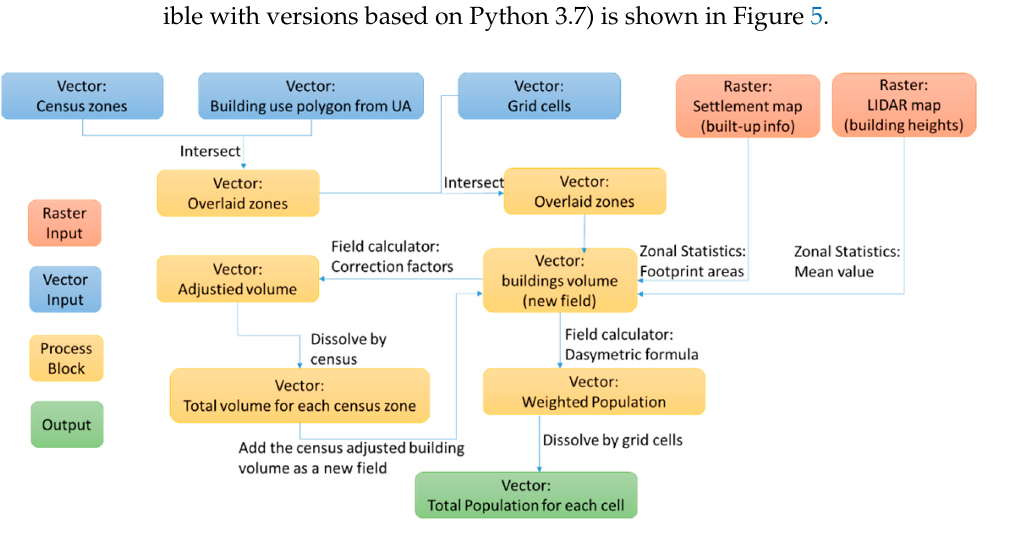
Table 4. List of ancillary data needed to evaluate SDG 11 indicators at intra-urban scale. bold format is used to identify the new indicators implemented.